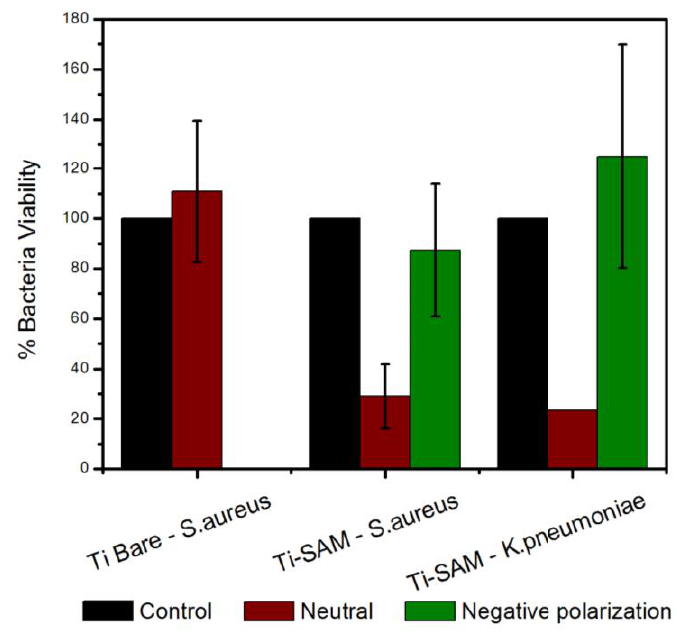
Figure 4. Bacteria viability of Ti bare and SAM-modified Ti ( 3 ) before (brown traces) and after negative polarization (green traces). Black traces show the control test.